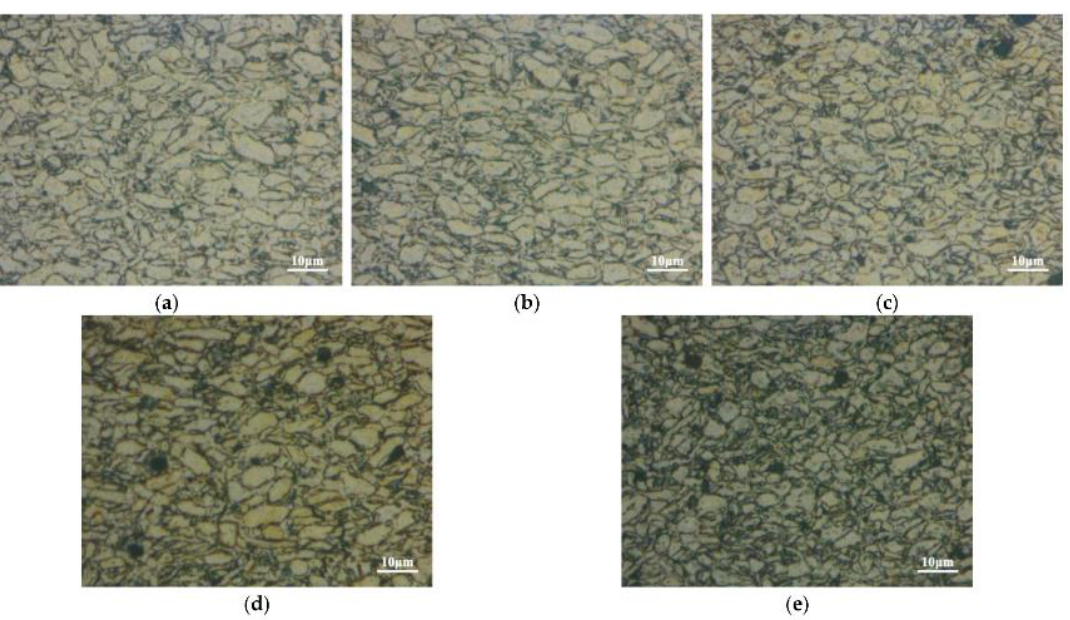
Figure 5. Images of CNT/Mg composites: ( a ) 0.5 vol.% CNTs; ( b ) 1 vol.% CNTs; ( c ) 1.5 vol.% CNTs; ( d ) 2 vol.% CNTs; ( e ) 2.5 vol.% CNTs. Reprinted from Ref. [8]. Copyright 2022 by the authors.